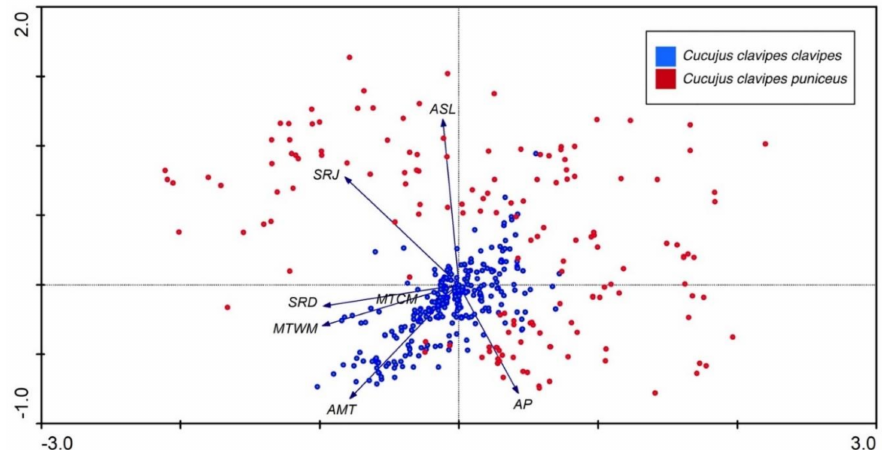
Figure 6. Results of PCA analysis for both subspecies of Cucujus clavipes . Environmental symbols: